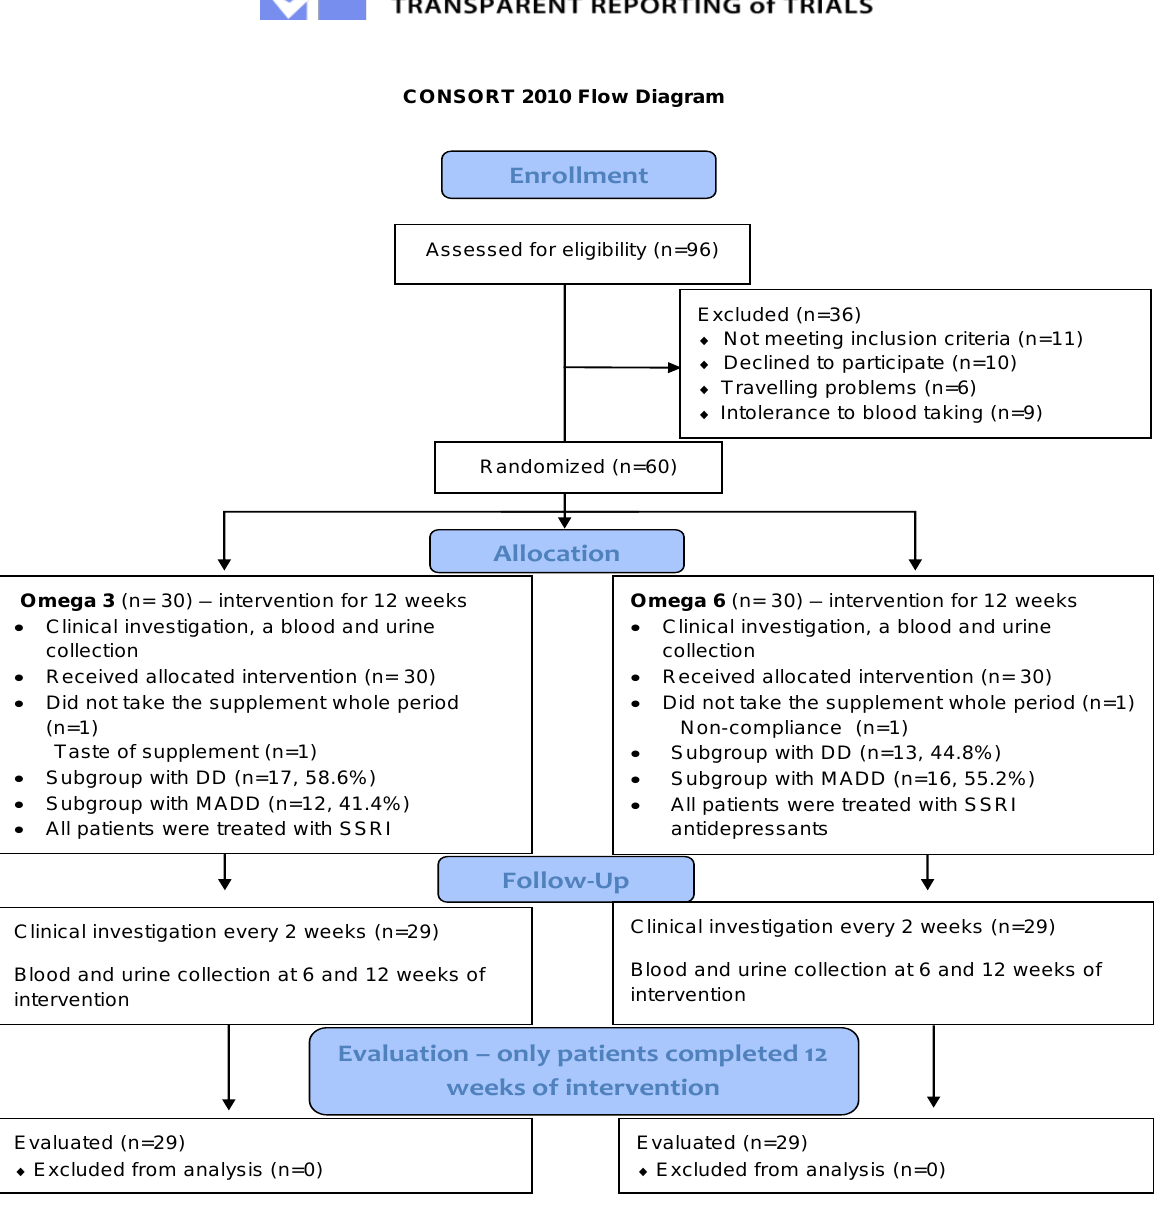
Figure 1. CONSORT 2010 Flow diagram . DD — depressive disorder; MADD-mixed anxiety and depressive disorder.